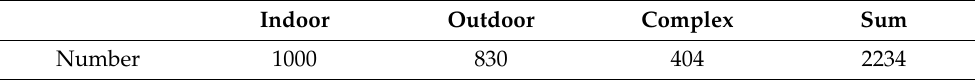
Table 1. The dataset of Macau license plate for test. Indoor Outdoor Complex Sum Number 1000 830 404